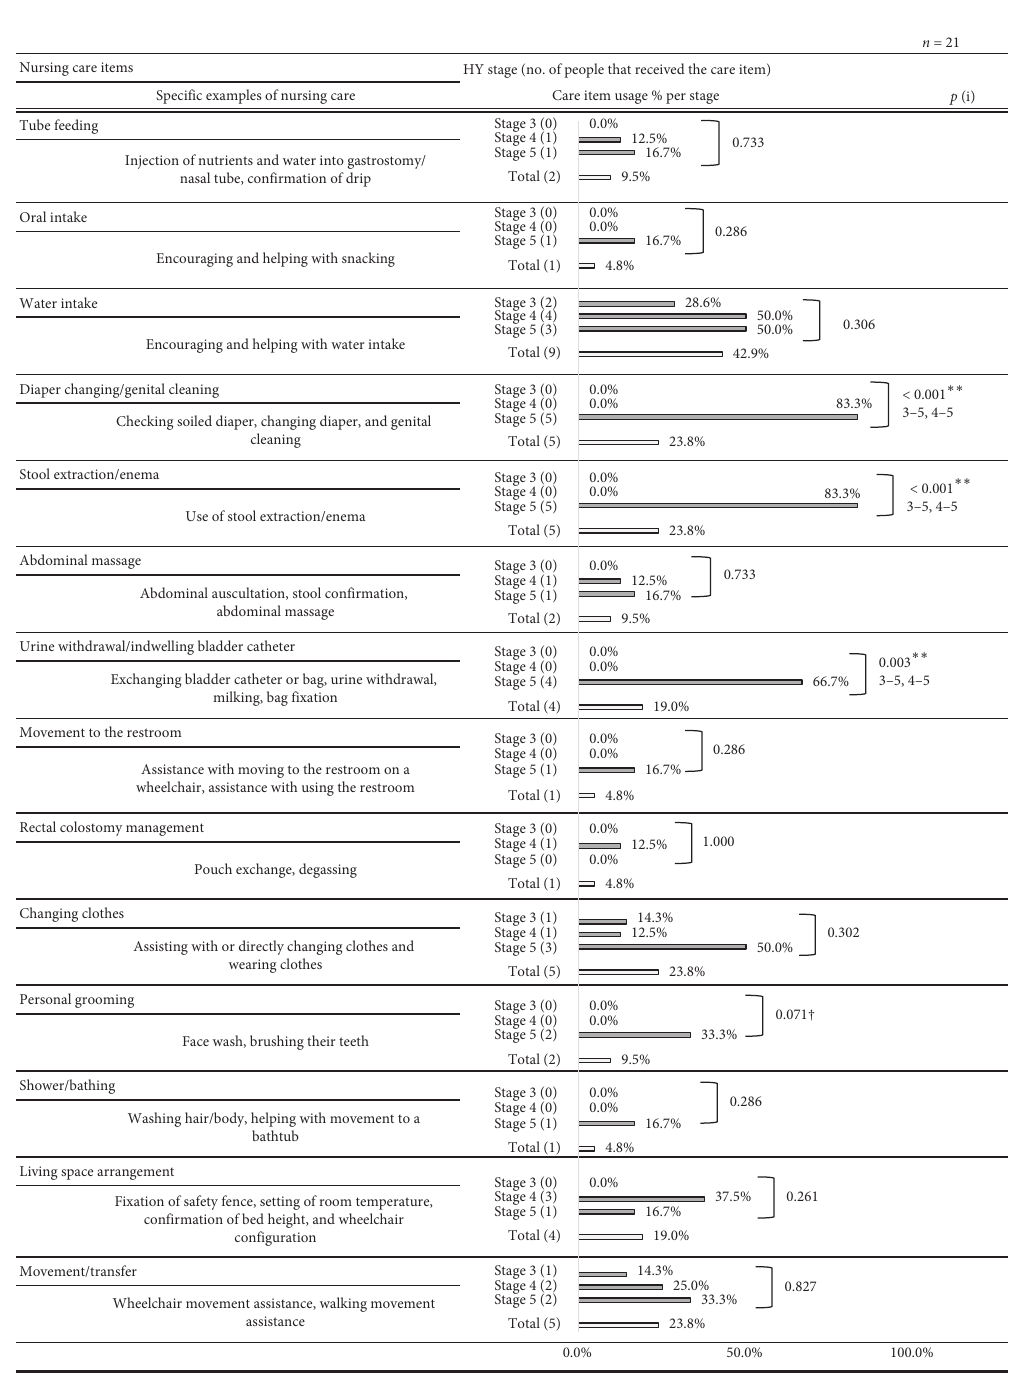
Figure 1: Comparisons of the percentage of nursing care provided at each HY stage. (i) Fisher’s exact test (every side) indicates significantly different pairs (p < 0.05) after Bonferroni correction; †p < 0.1, ∗ p < 0.05, and ∗∗ p < 0.01; p values and percentages have been rounded off.